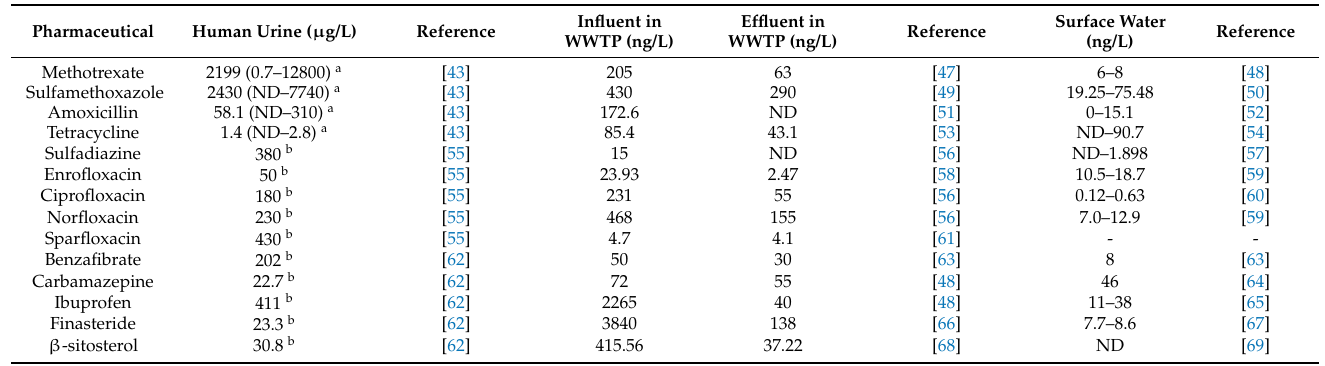
Table 3. Concentration distribution of pharmaceutical contaminants in human urine, WWTPs, and surface water.